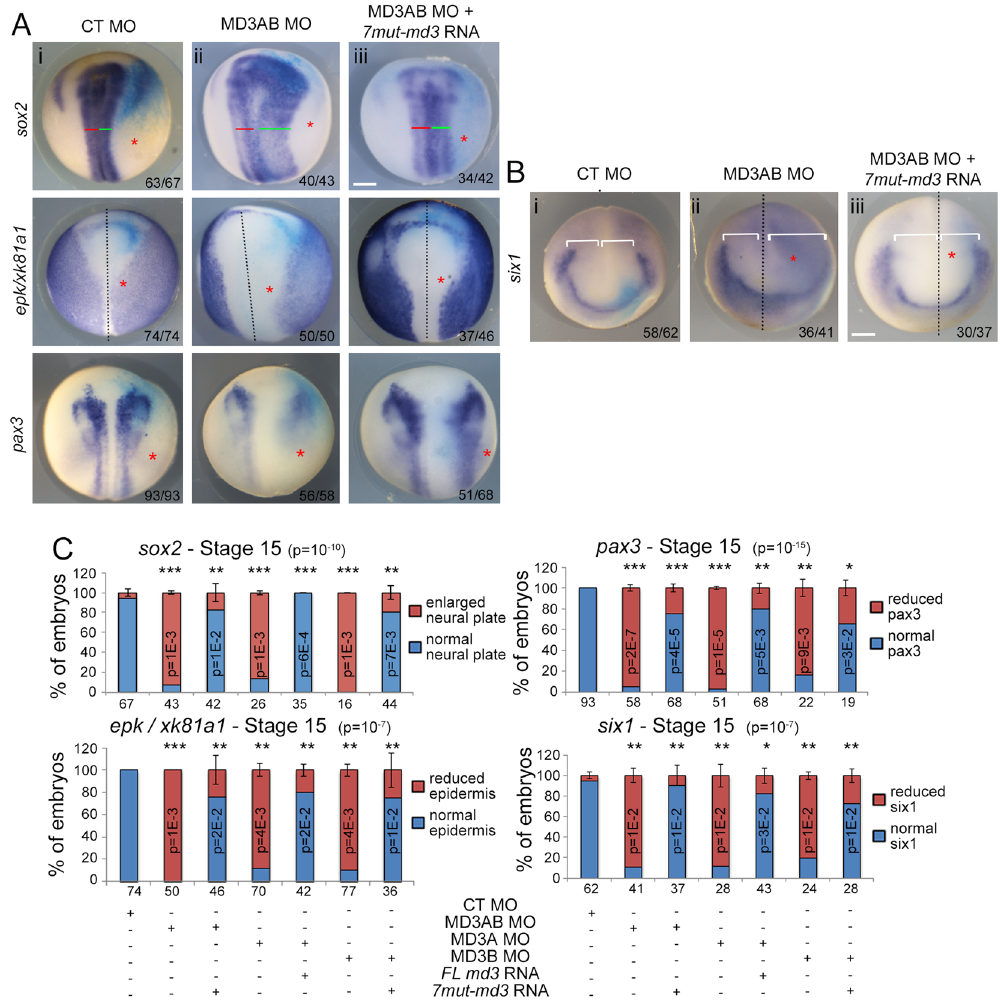
Figure 5. MarvelD3 is required for neural plate border positioning. ( A ) Neural plate border positioning was analysed at stage 15 by WISH with probes against the neural/non-neural ectoderm markers ( sox2 ; epk/xk81a1 ) and neural plate border marker pax3 , while placode formation was analysed with ( B ) a pan-placodal marker, six1 , in control morpholino- ( A , i; B , i), MD3AB morpholino-injected embryos ( A , ii; B , ii) and embryos co- injected with MD3AB morpholino + 7mut-MarvelD3 mRNA ( A , iii; B , iii). ( A ) Red and green lines demarcate medio-lateral expansion of sox2 ; ( A , B ) black doted lines identify the midline; ( B ) white brackets indicate the distance from the midline; the number of embryos analysed is indicated at the bottom right of each panel; red asterisk, injected side of the embryo with the light blue β -galactosidase staining; scale bars, 500 µ m. ( C ) Quantification of neural crest induction was performed for twist , snai1 , foxd3 and snai2/slug . ANOVA values are provided in parenthesis in the title of each graph. Student t-test p values and the number of embryos analysed are indicated; blue bar, normal neural plate (NP; sox2 ) or epidermis ( epk/xk81a1 ) or neural plate border ( pax3 , six1 ); red bar, enlarged neural plate ( sox2 ) or reduced epidermis ( epk/xk81a1 ) or reduced neural plate border ( pax3 , six1 ). See Fig. S2 for images of embryos injected with individual MD3A or MD3B morpholinos and corresponding rescue